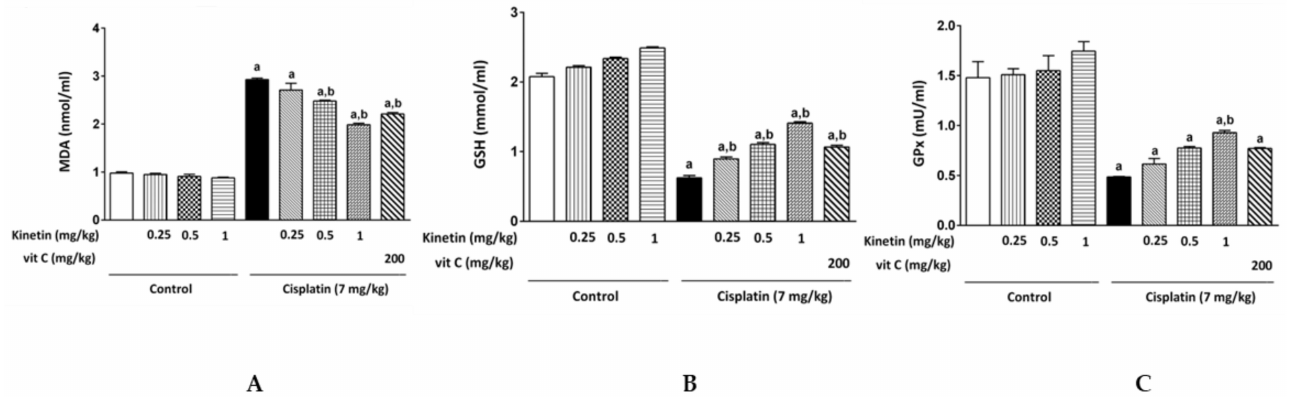
Figure 4. Effect Effect of kinetin on redox status in lymphocytes. Effect of different doses of kinetin and vitamin C on ( A ) MDA, ( B ) GSH and ( C ) GPx in lymphocytes. a Significantly different from control group, b significantly different from cisplatin group according to one-way ANOVA followed by Tukey–Kramer multiple comparisons test at p < 0.01, ( n = 6). Tests were performed as described in Research Design and Methods. MDA: malondialdehyde, GSH: glutathione, GPx: Glutathione peroxidase, Vit C: vitamin